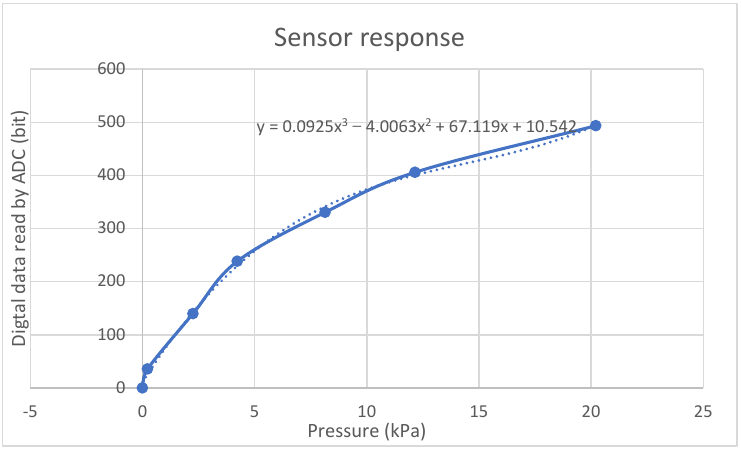
Figure 5. Sensor response graph.